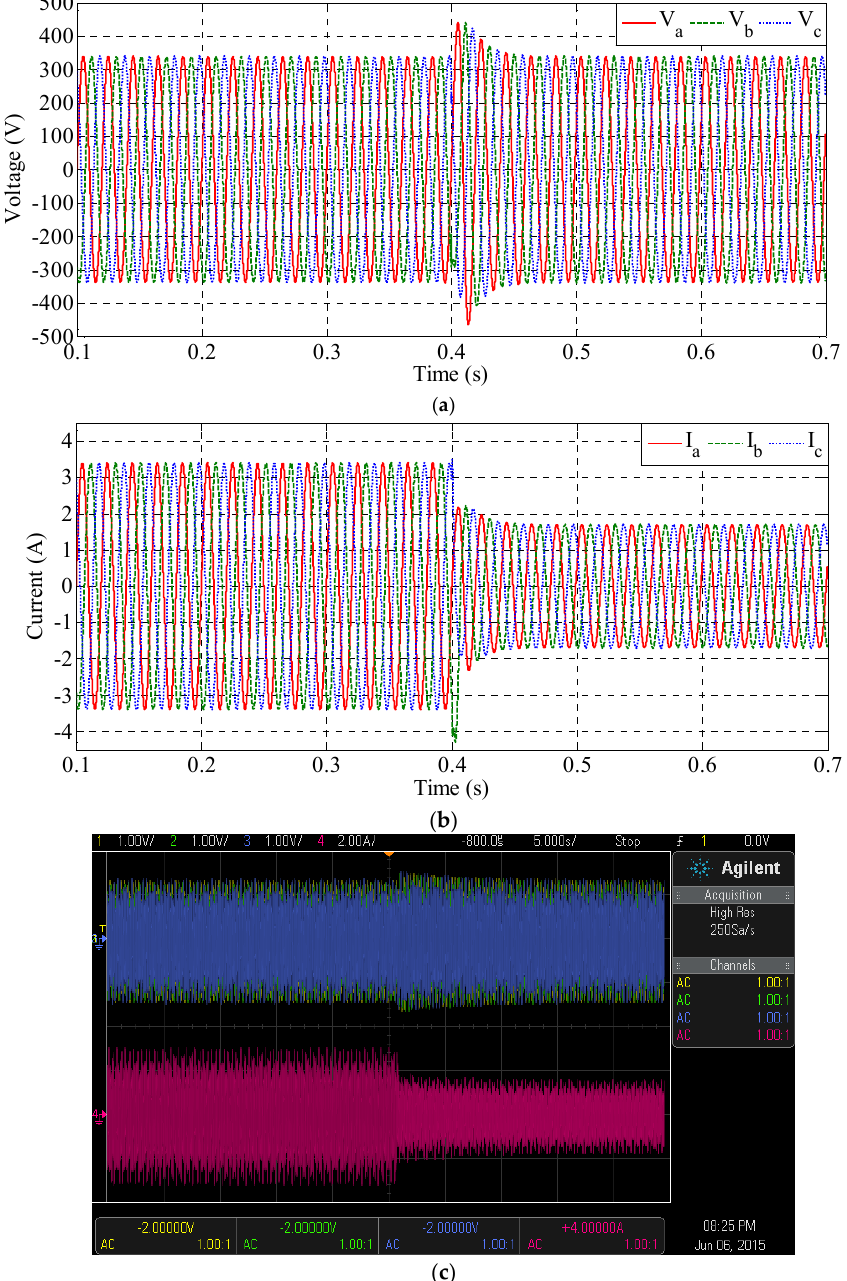
Figure 18. Output waveforms with R load decreasing from 1500 W to 750 W. ( a ) Simulation voltage waveforms; ( b ) simulation current waveforms; and ( c ) experimental voltage and current waveforms (Ch. 1, Ch. 2, Ch. 3, and Ch. 4 for V a , V b , V c , and I a ,